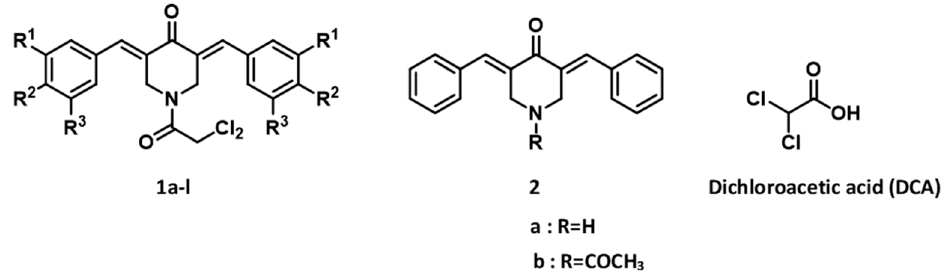
Figure 1. The structures of the compounds in series 1 , 2 and dichloroacetic acid (DCA). The aryl substituents in series 1 are indicated in Table 1. Table 1. Evaluation of 1a – l, 2a , b against Ca9-22, HSC-2, HSC-3, and HSC-4 cancer cells.